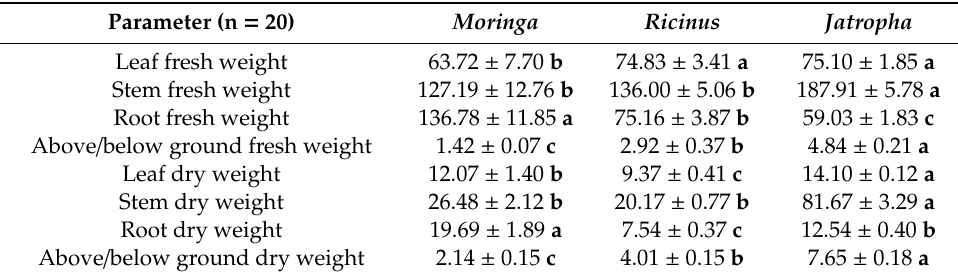
Table 9. Average ( ± SE) fresh and dry weight (g) of Moringa oleifera , Ricinus communis , and Jatropha curcas 83 days after root pruning and transplanting.